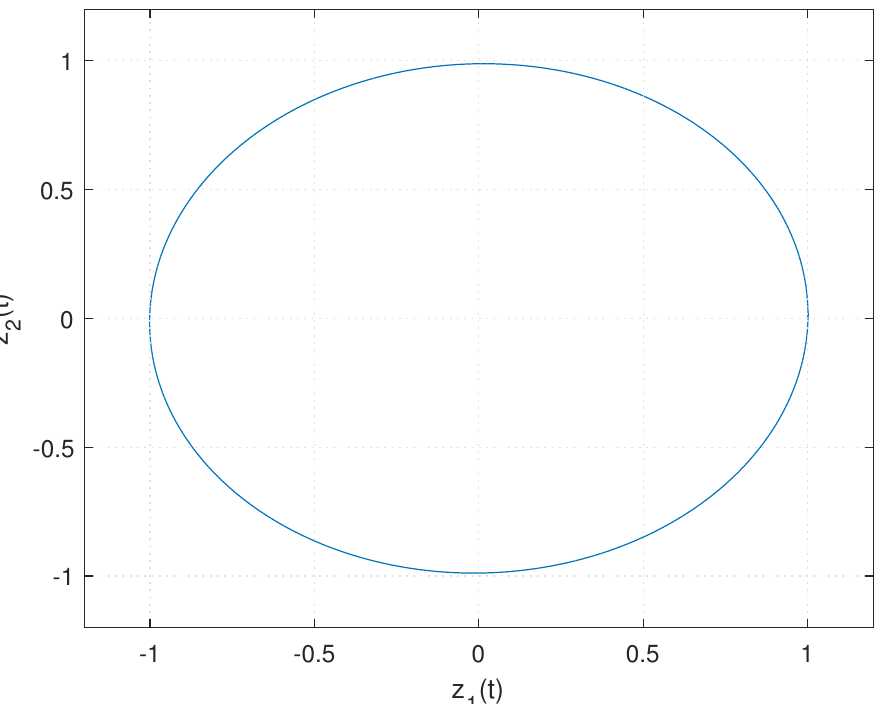
Figure 1. Response of the open-loop system state for Example 1.